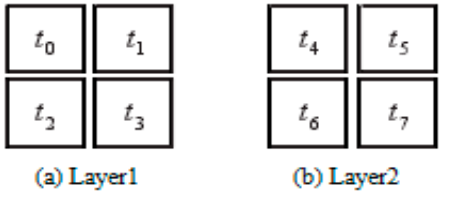
Figure 5. 3D NoC topological structure.